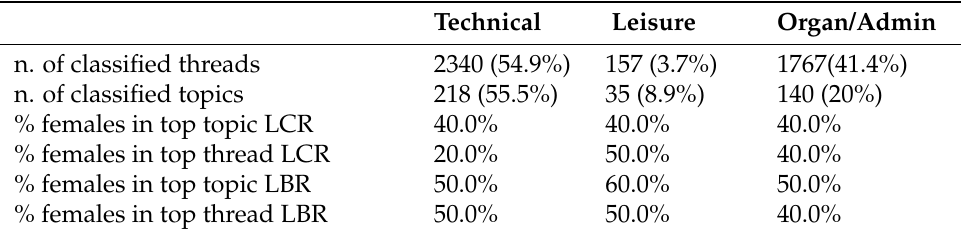
Table 3. Leadership and brokerage as a function of topics/threads